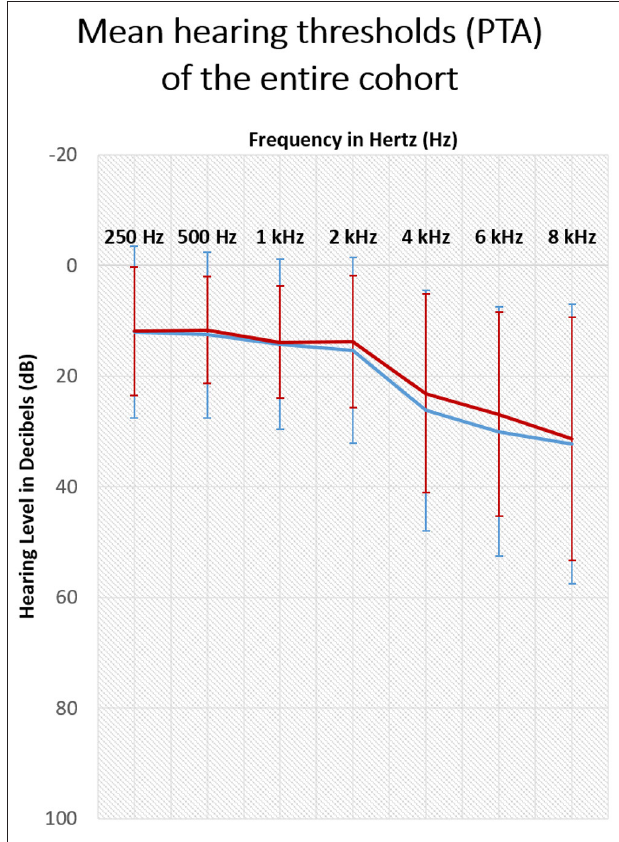
of the sample with SD. The red line: right ear, blue line: left